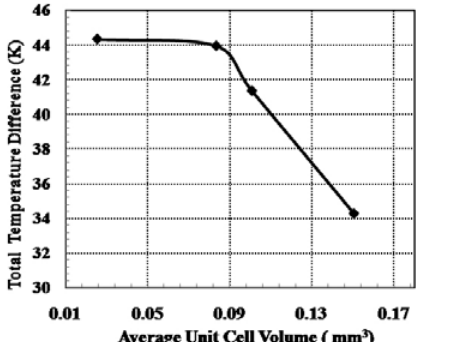
Fig. 5. Grid independence analysis of maximum swirl